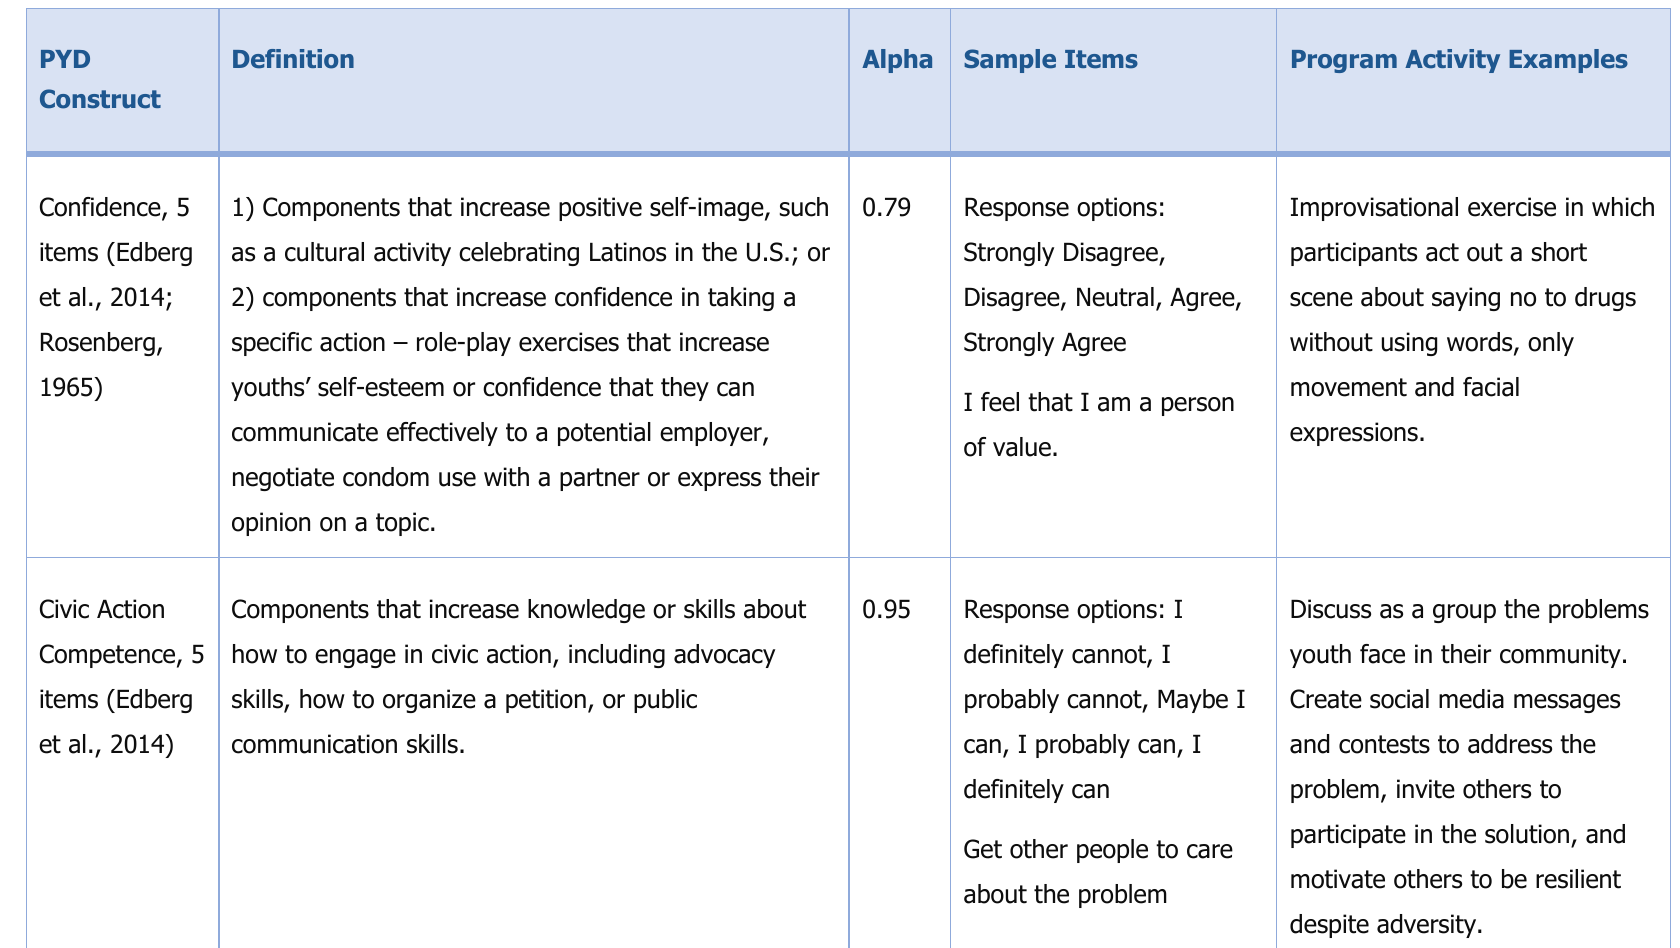
Table 1. Changes in Confidence, Civic Action Competence, Community Connection, and Friend/Peer Connection